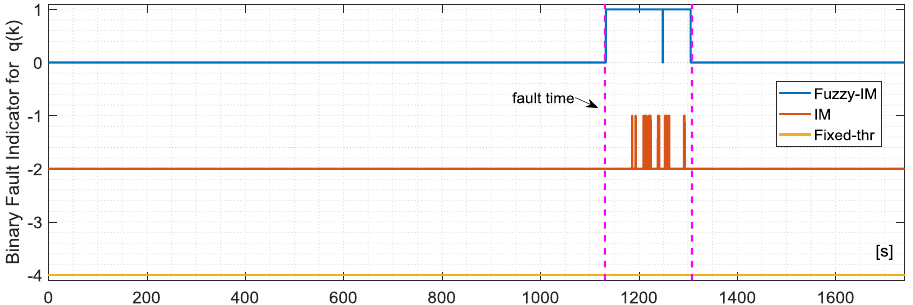
Figure 9. Evolution of the NR residual for the q ( k ) sensor and the corresponding FD intervals as long as the binary fault indicator for the FIM approach ( Upper ) and Fixed-thresholds approach ( Lower ) in case of validation flight number-1.